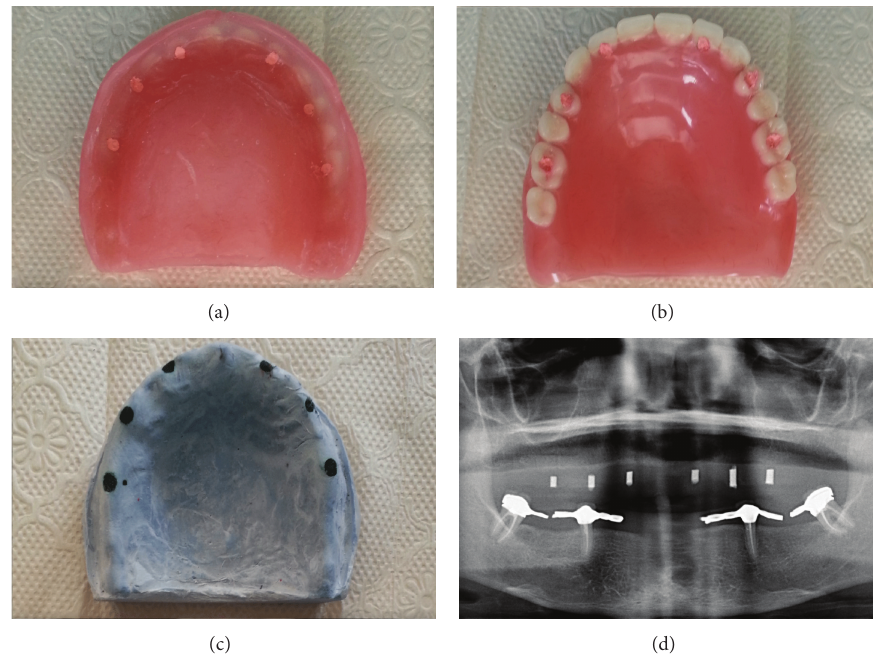
Figure 3: ((a), (b)) The images of temporary denture with gutta percha filling material and (c) stone model that the estimated implant places were marked. (d) Orthopantomographic view of the case with gutta percha filled temporary